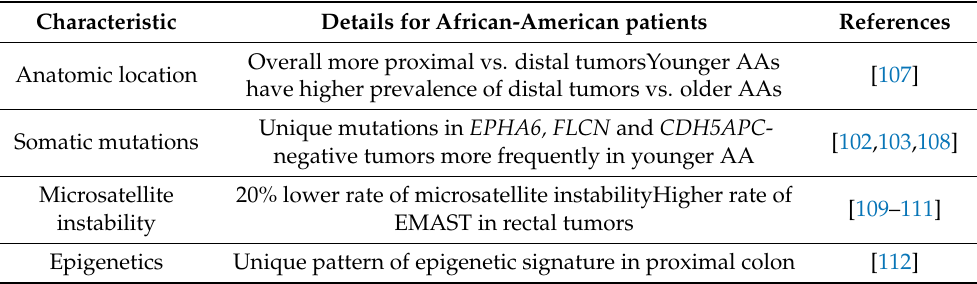
Table 3. CRC tumor characteristics in African-American vs. White patients. In most cases, these characteristics have not been studied specifically in the context of early-onset colorectal cancer unless otherwise